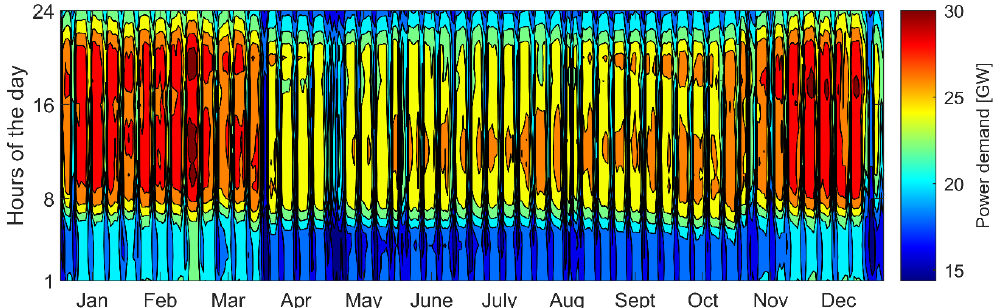
Figure 5. Assumed power demand shown in an hourly temporal resolution for 2030.